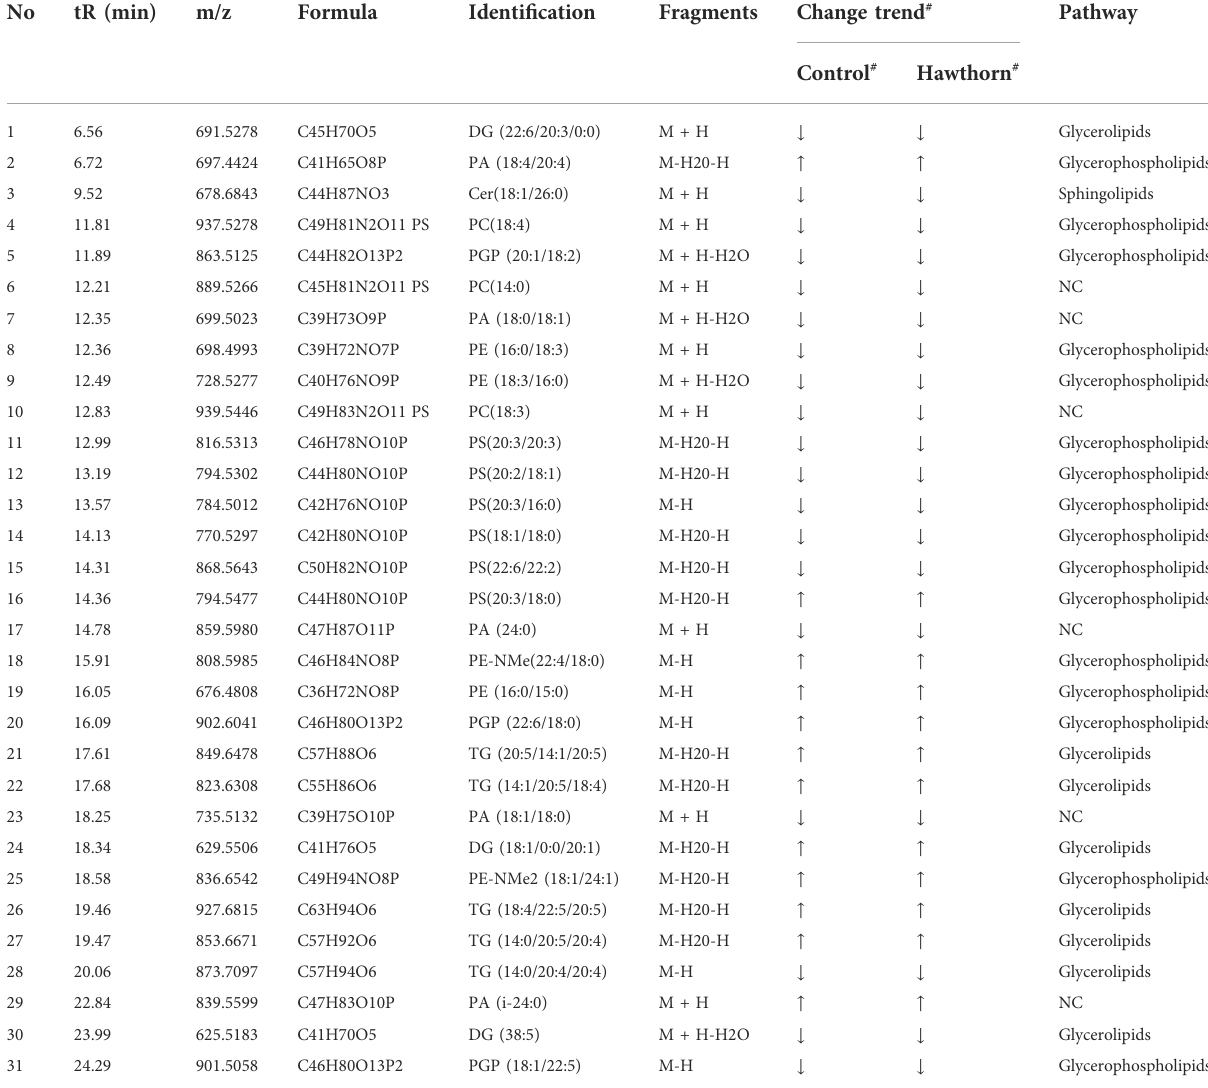
TABLE 1 Identi fi cation of ions and their alteration trend in positive and negative